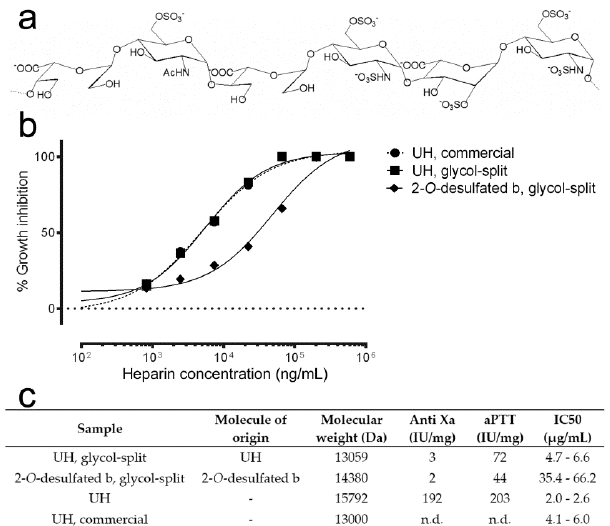
Figure 4. Effect of glycol-split on the in vitro antimalarial activity of heparin. ( a ) Structure of the heparin chain after glycol-split treatment. ( b ) In vitro P. falciparum growth inhibition activity assay of heparin fractions with and without glycol-split. ( c ) Description of the heparin samples tested in panel ( b ). n.d.: not determined.